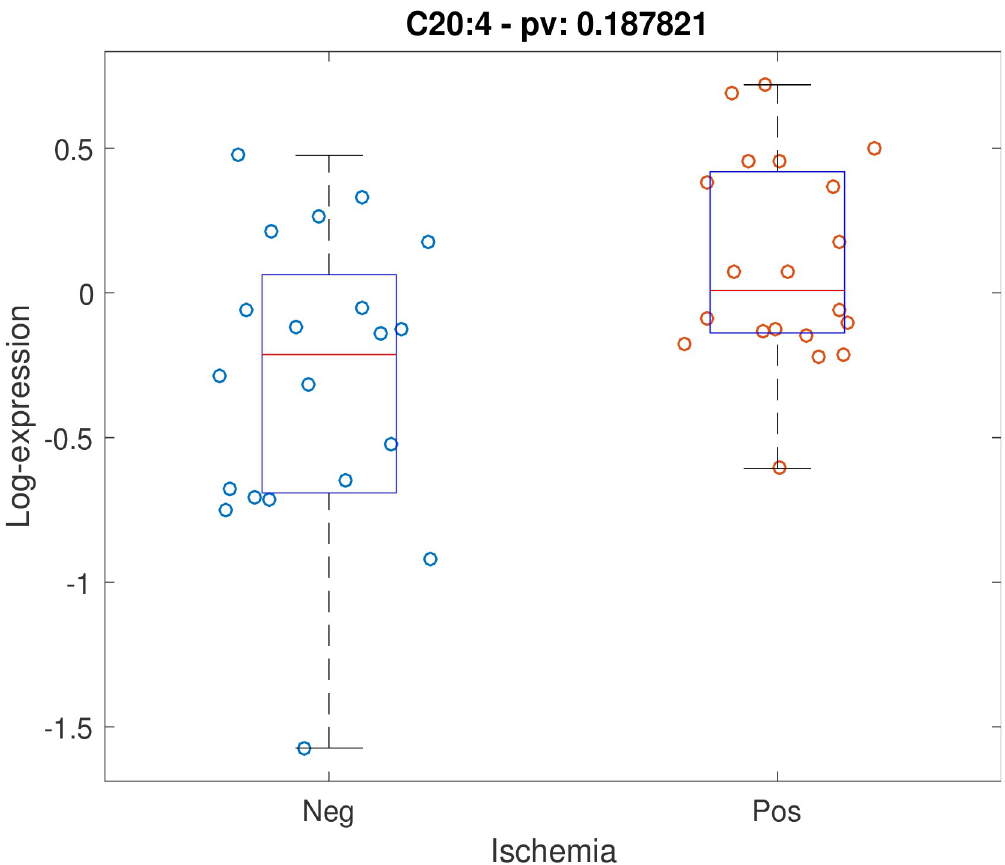
Fig 4. Scatter plot of stress-delta in C20:4 for patients who were positive versus negative for ischemia. When assessing changes in metabolite levels across timepoints while controlling for age, gender and BMI, 5 metabolites had FDR < 0.2: alanine, C14:1-OH, C16:1, C18:2, C20:4.